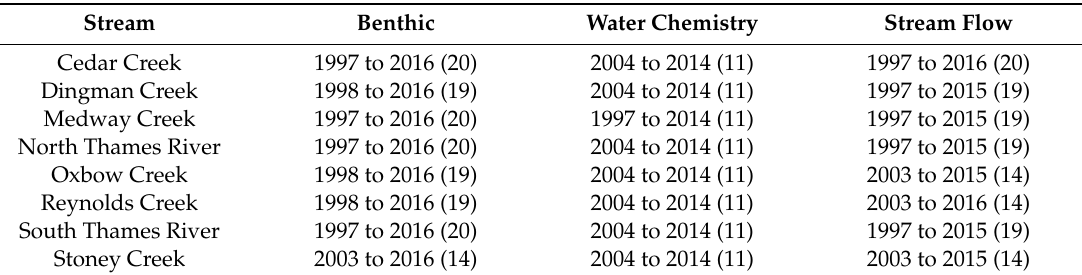
Table 2. Years for which monitoring data of benthic macroinvertebrates, water chemistry, and stream flow were available for eight streams in the Upper Thames River Basin of southern Ontario, Canada. Number in parentheses indicates total number of years